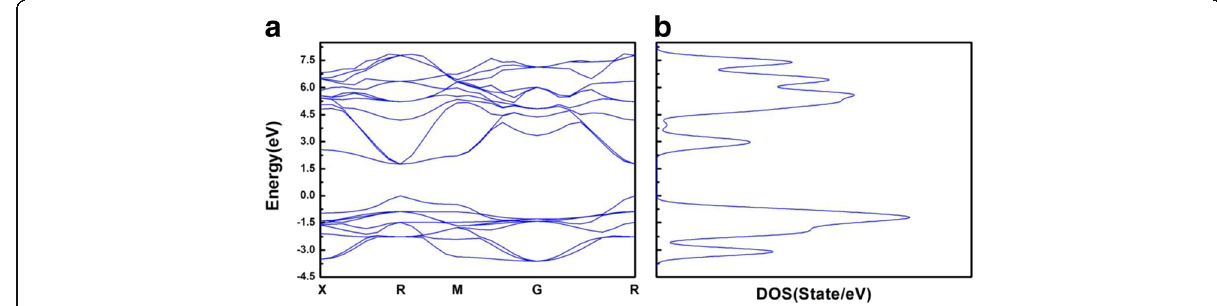
Fig. 2 a – b The band structure and density of states of CsPbI